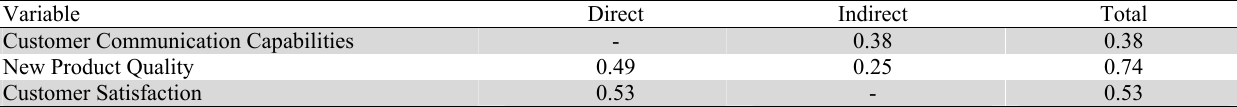
The summary of direct and indirect